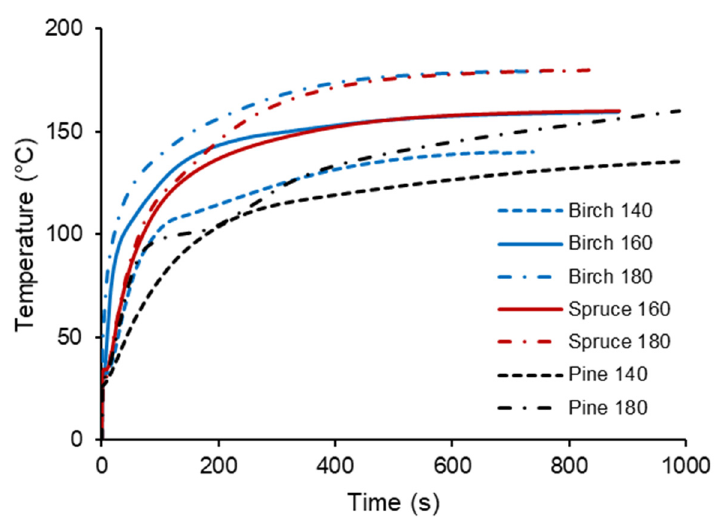
Figure 1. Representative core temperature profiles for consolidated panels with different veneer types and pressing temperatures using PLA foils (0.3 mm).